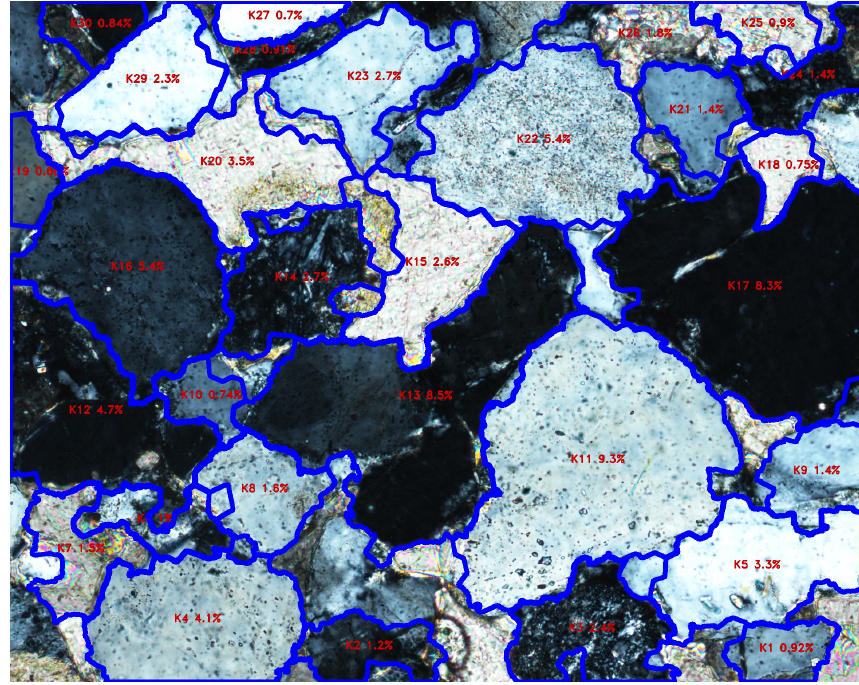
Figure 8. Final result of the area calculation for 0°